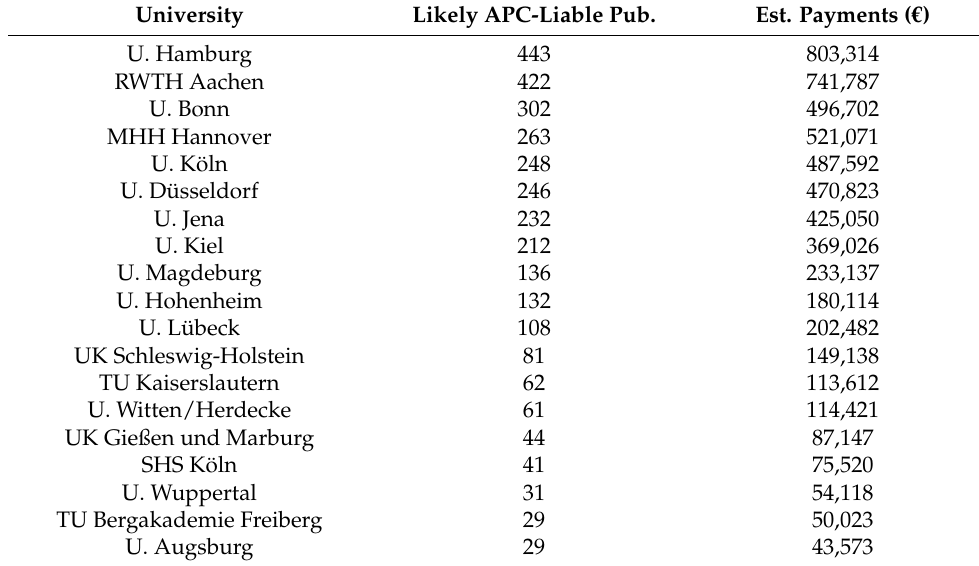
Table 2. Non-OpenAPC universities, APC-liable publications in